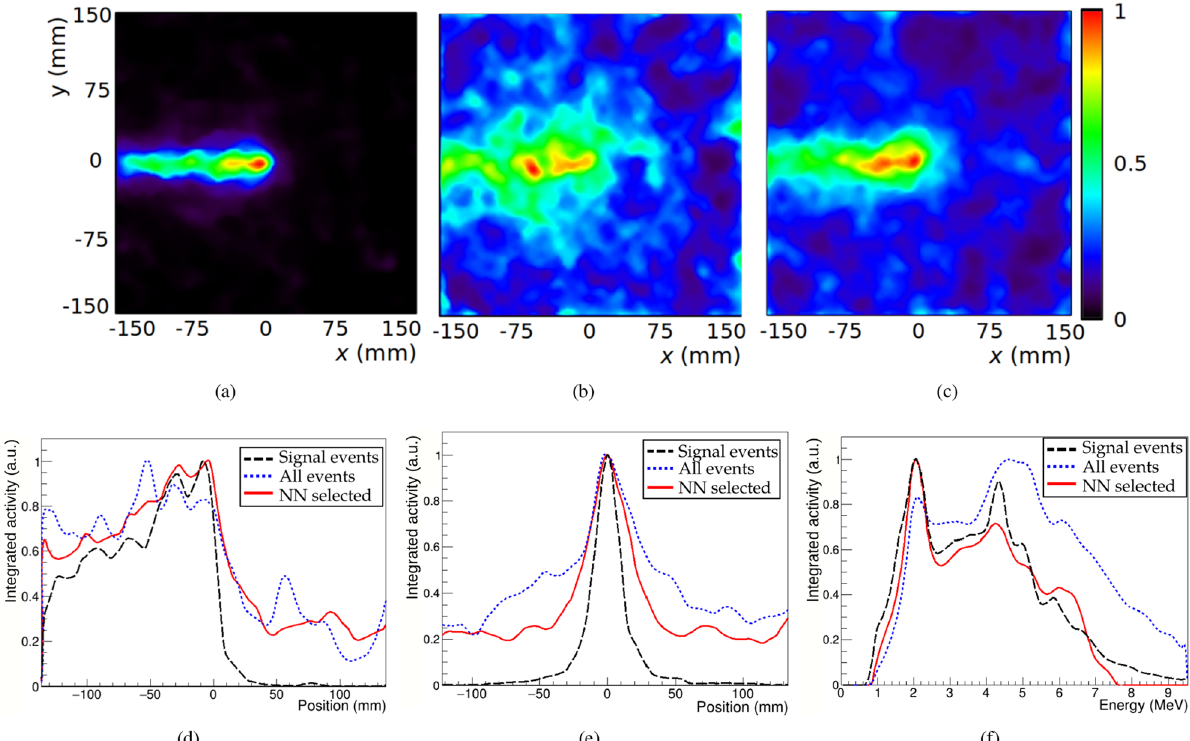
Figure 1. Reconstructed images at 4.4 MeV using three different simulated data sets: only true signal events ( a ), all events ( b ) and events selected by the trained NN ( c ). ( d ) Line profiles along the beam direction from the above images. ( e ) Transverse line profiles at the maximum position. ( f ) Energy spectra recovered after integration over the reconstructed image spatial domain.